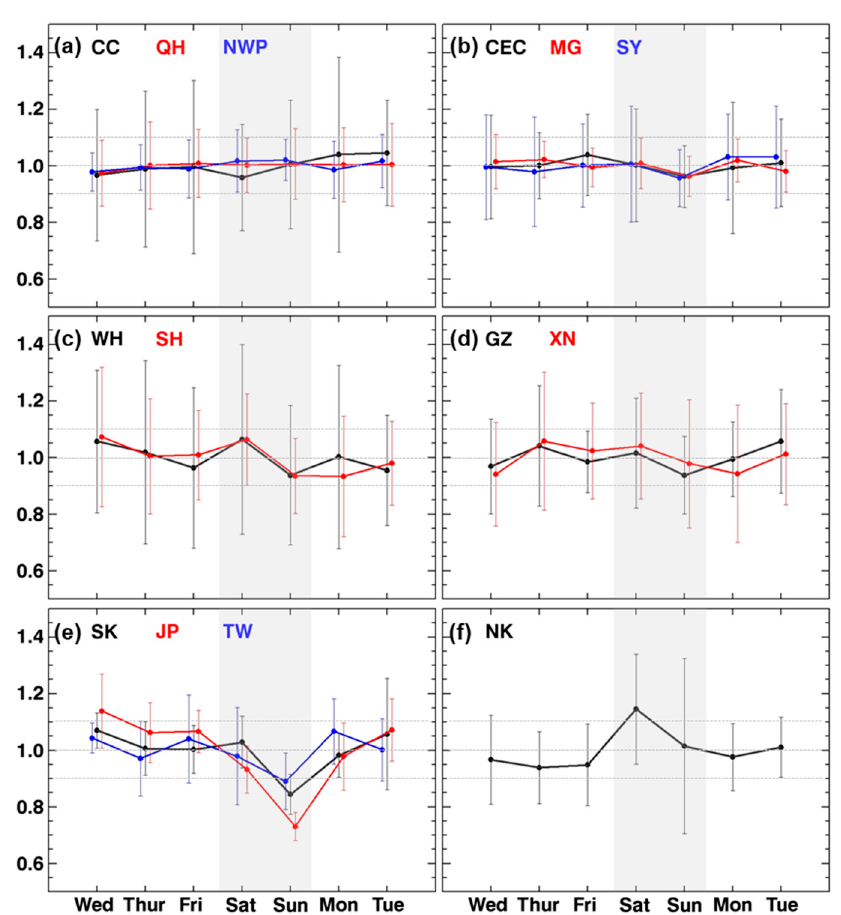
Figure 8. Weekly cycles of Ω normalized to 10-year averaged Ω for ( a ) CC, QH, and NWP, ( b ) CEC, MG, and SY, ( c ) WH and SH, ( d ) GZ and XN, ( e ) SK, JP, and TW, and ( f ) NK. Vertical bars represent 1- σ standard deviation. Gray shaded areas represent the weekend.